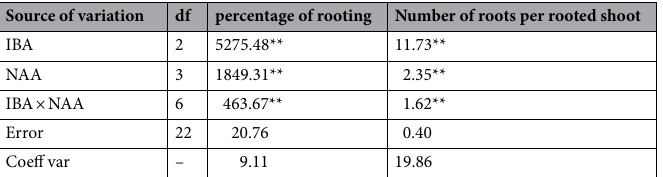
Table 3. Analysis of variance of IBA and NAA treatments on the rooting of R. coriaria. *; **Significant at the 0.05, 0.01 probability level respectively.